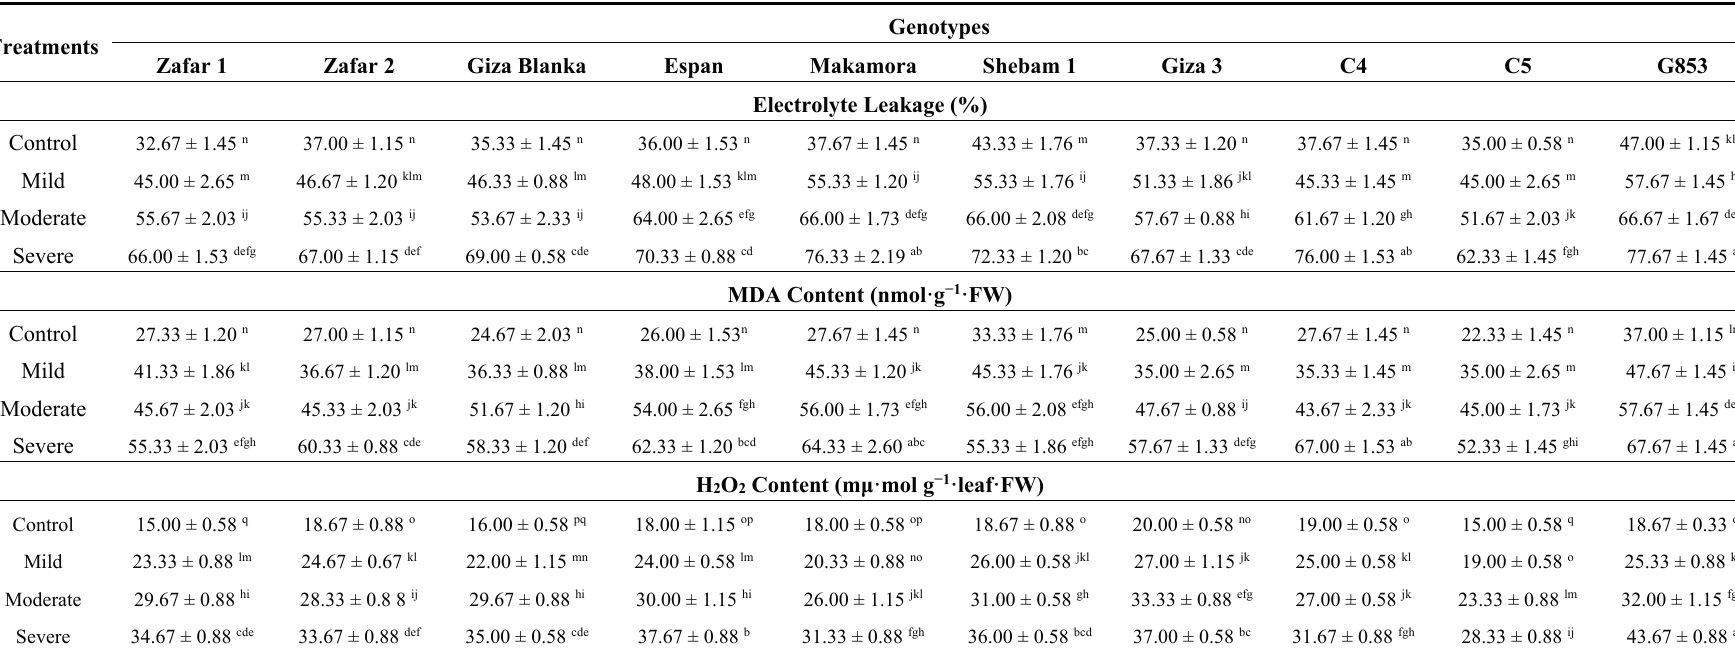
Table 3. Effect of drought stress on electrolyte leakage and content of malondialdehyde (MDA) and hydrogen peroxide (H 2 O 2 ) in faba bean